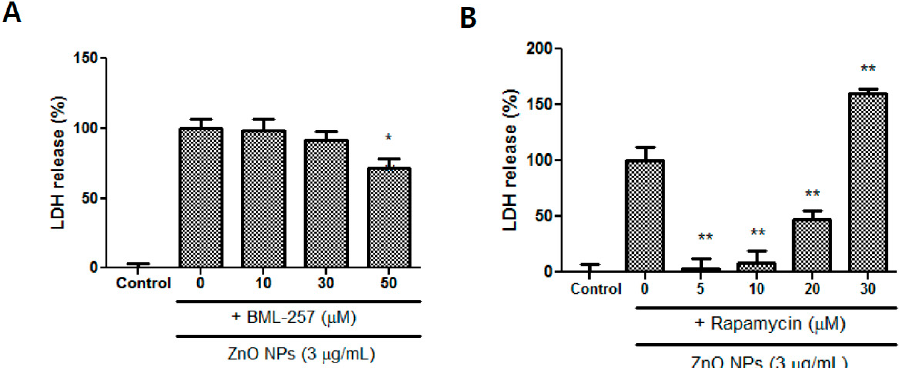
Figure 9. Protective effects of BML-257 ( A ) and rapamycin ( B ) on ZnO NP-induced toxicity in primary astrocyte cultures. At a higher dose (30 μ M) of rapamycin, ZnO NP-mediated toxicity was potentiated. Cytotoxicity was evaluated using an LDH release assay. Data represents the mean ± SEM. * p < 0.05, ** p < 0.01 compared to ZnO NPs ( n = 4).